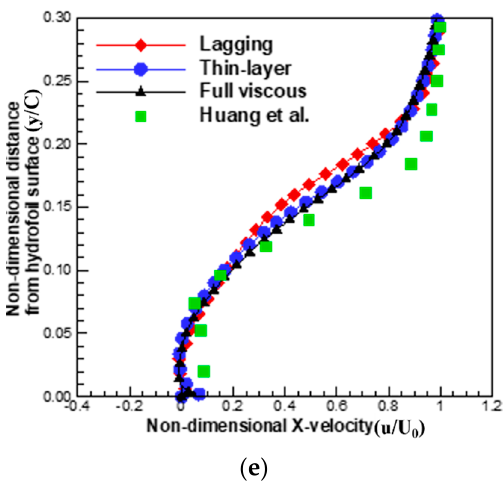
Figure 3. Comparison of time-averaged x-directional velocity distribution with experimental results by Huang et al. [41]: ( a ) x / C = 0.2; ( b ) x / C = 0.4; ( c ) x / C = 0.6; ( d ) x / C = 0.8; and ( e ) x / C = 1.0.